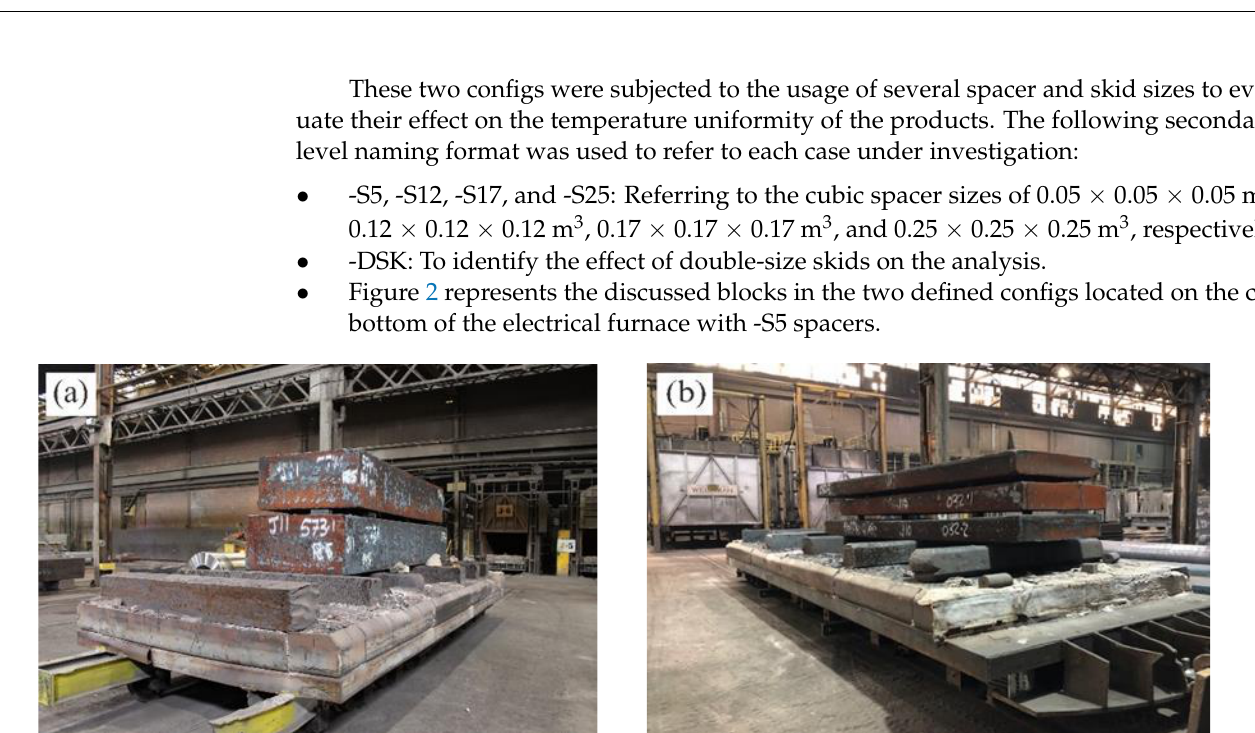
Figure 2. Industrial scale stacking patterns: ( a ) Config-1-S5 and ( b ) Config-2-S5.